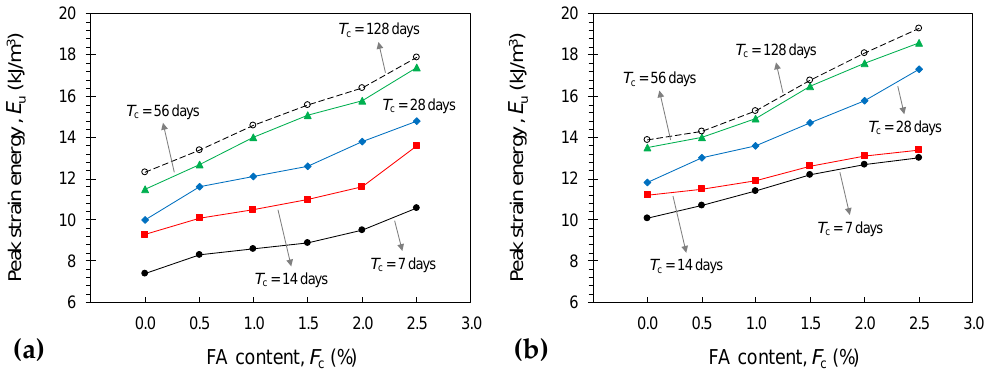
Figure 7. Variations of peak strain energy E u against FA content for the samples tested at various curing times: ( a ) M 1.5 F y T z ; ( b ) M 2.5 F y T z ( y = {0, 0.5, 1.0, 1.5, 2.0, 2.5} and z = {7, 14, 28, 56, 128}).